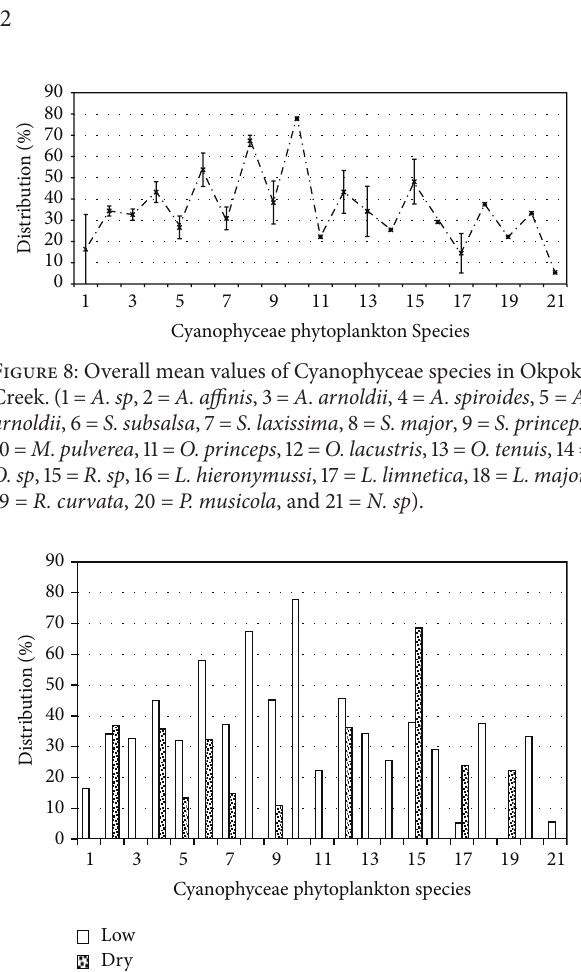
Figure 9: Variation of Cyanophyceae species in relation to tide in Okpoka Creek. (1 = A. sp , 2 = A. affinis , 3 = A. arnoldii , 4 = A. spiroides , 5 = A. arnoldii , 6 = S. subsalsa , 7 = S. laxissima , 8 = S. major , 9 = S. princeps , 10 = M. pulverea , 11 = O. princeps , 12 = O. lacustris , 13 = O. tenuis , 14 = O. sp , 15 = R. sp , 16 = L. hieronymussi , 17 = L. limnetica , 18 = L. major , 19 = R. curvata , 20 = P. musicola , and 21 = N. sp ).